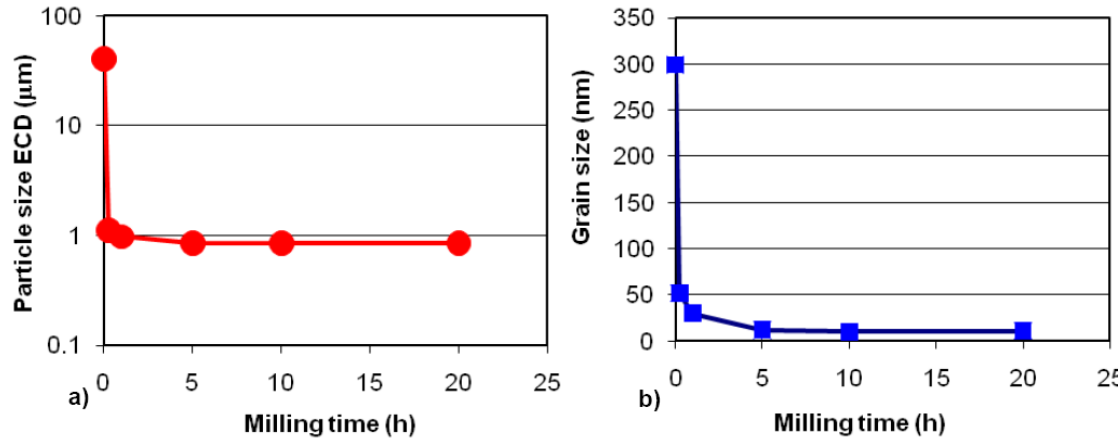
Figure 1. Simultaneous reduction of (a) the particle size and (b) the grain size as a function of ball milling time of MgH . Adapted from 2